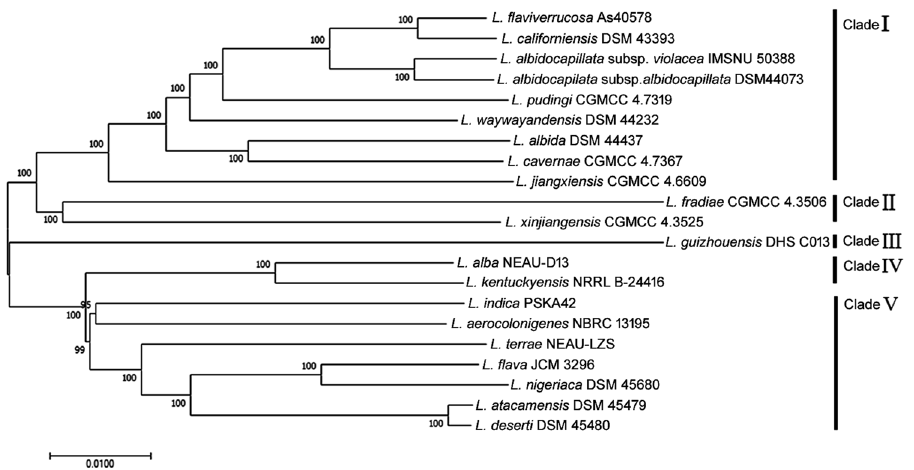
Figure 4. Neighbor-joining phylogenetic relationship based on core proteome of Lentzea species. Numbers at nodes refer to bootstrap values based on 1000 replicates. Bar, 0.01 means amino acid substitutions per 100 amino acid